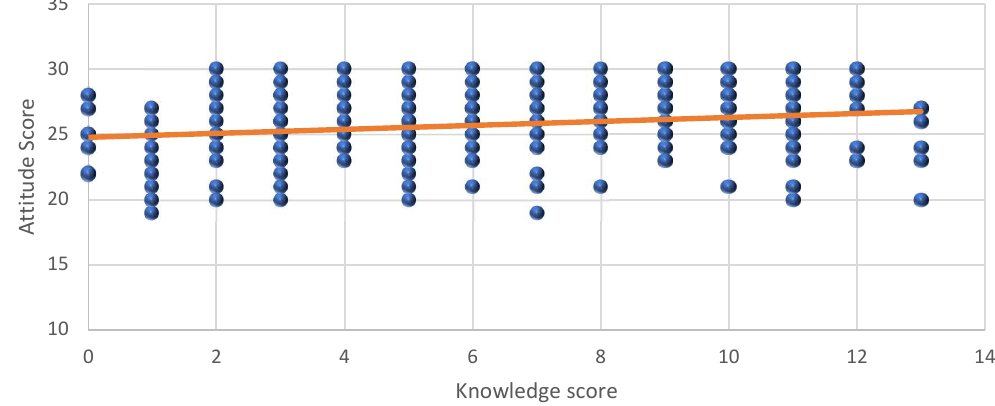
Figure 2. Correlation (Pearson-R) between the mean score of knowledge and attitude.